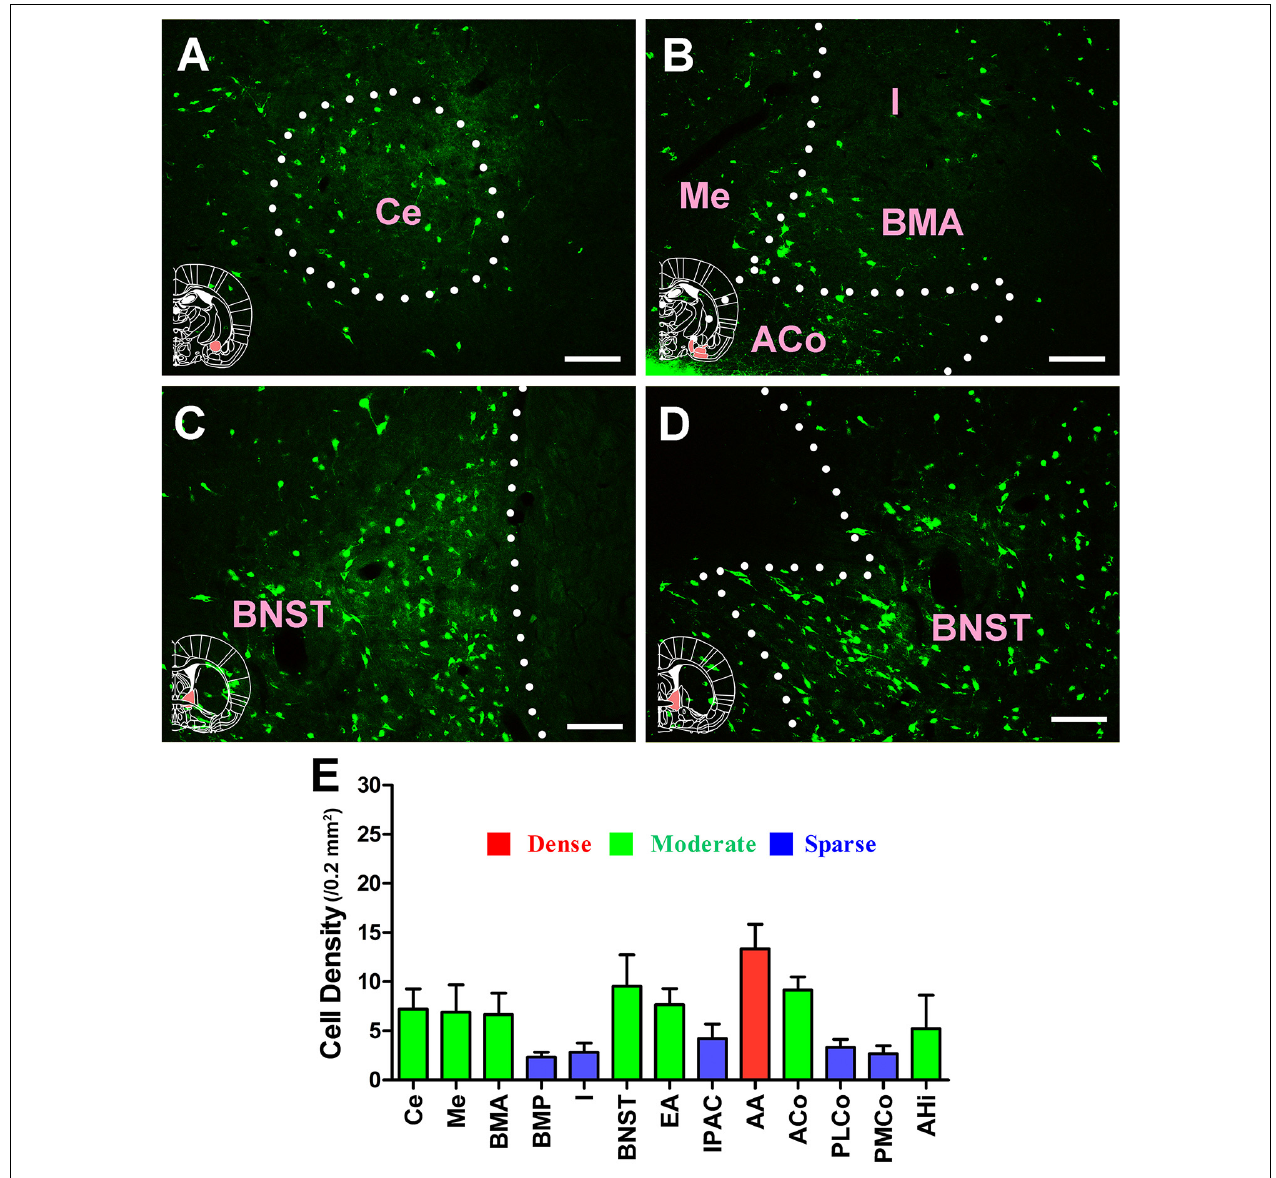
FIGURE 8 | Distribution of cholera toxin subunit B-positive neurons in the amygdaloid structures. (A–D) The positive neurons in Ce, Me, I, BMA, ACo, and BNST. (E) Statistics of the input amounts of cholera toxin subunit B-positive cells from the amygdaloid structures to the CSF-contacting nucleus (mean ± SD, n = 6; Ce, central amygdaloid nucleus; Me, medial amygdaloid nucleus; I, intercalated nuclei of the amygdala; BMA, basomedial amygdaloid nucleus anterior part; ACo, anterior cortical amygdaloid nucleus; BNST, bed nucleus of the stria terminalis). Bar = 100 µ m.